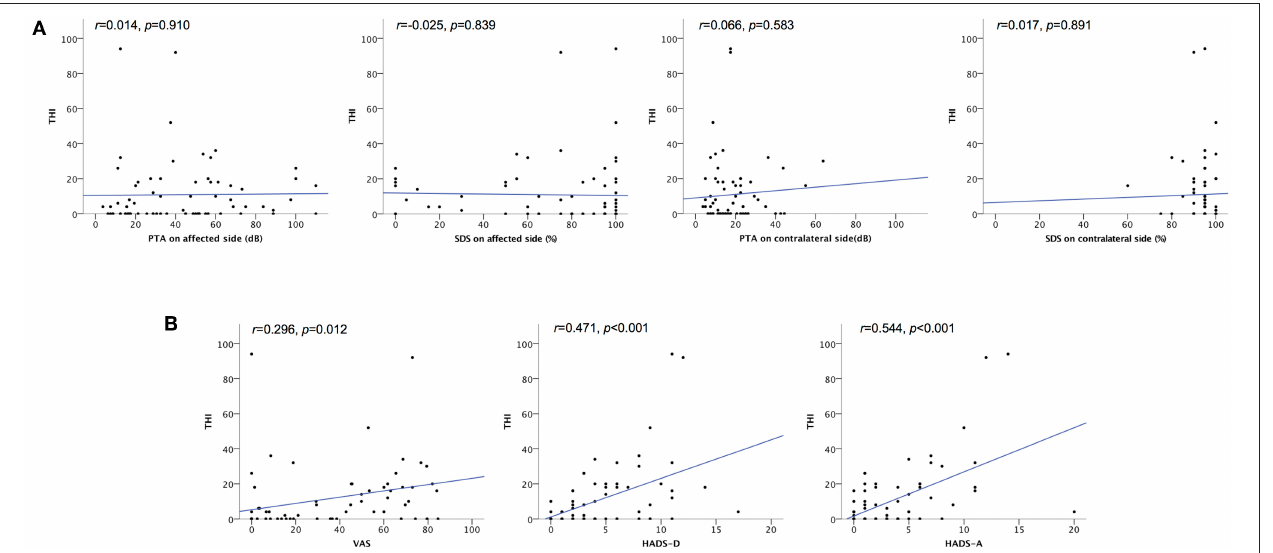
FIGURE 3 | Scatter plots showing correlation analyses of the relationship between tinnitus severity and hearing impairment, depression, and anxiety. (A) Correlation between THI scores and hearing threshold. No statistical correlation was found between tinnitus severity (THI scores) and auditory thresholds. (B) Correlation between THI scores and VAS, HADS-D, and HADS-A scores. Pearson’s correlation analysis revealed a significant correlation between THI scores and VAS, HADS-D, and HADS-A scores. HADS-A, Hospital Anxiety and Depression Scale Anxiety score; HADS-D, Hospital Anxiety and Depression Scale Depression score; PTA, pure